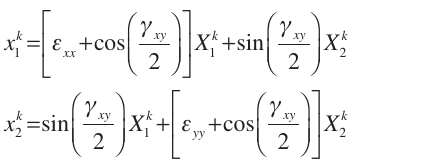
Figure 7 RVE original corner locations and